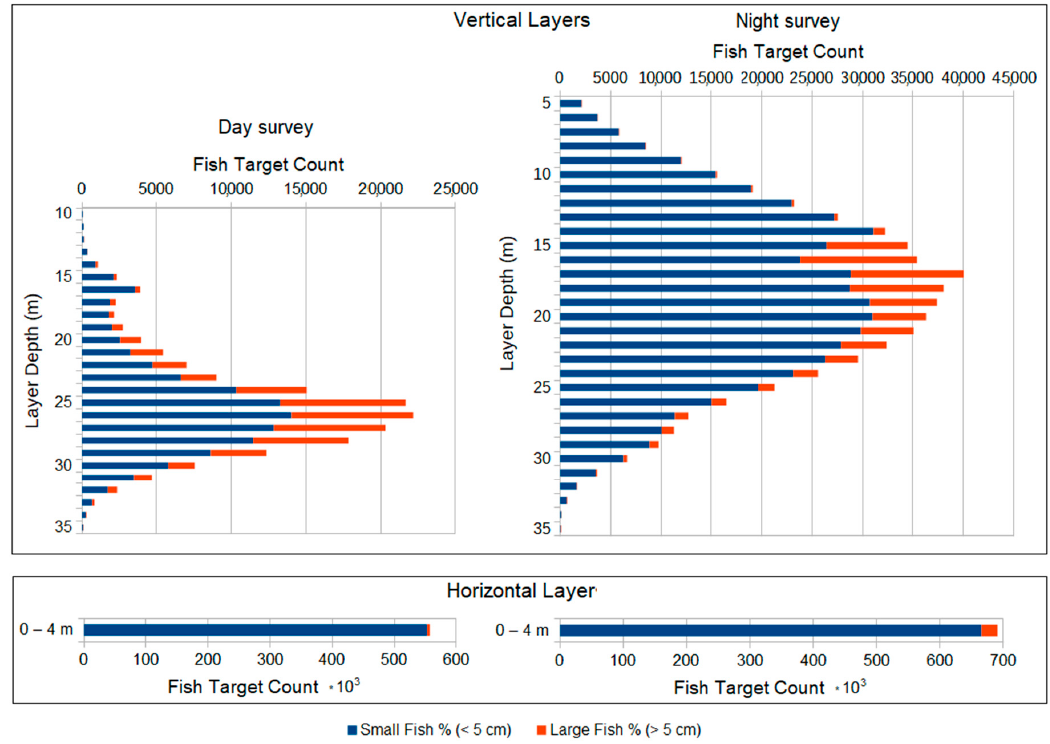
Figure 14. Proportional fish distribution by size, depth and time of day. Layers with < 100 detected individuals excluded for clarity.